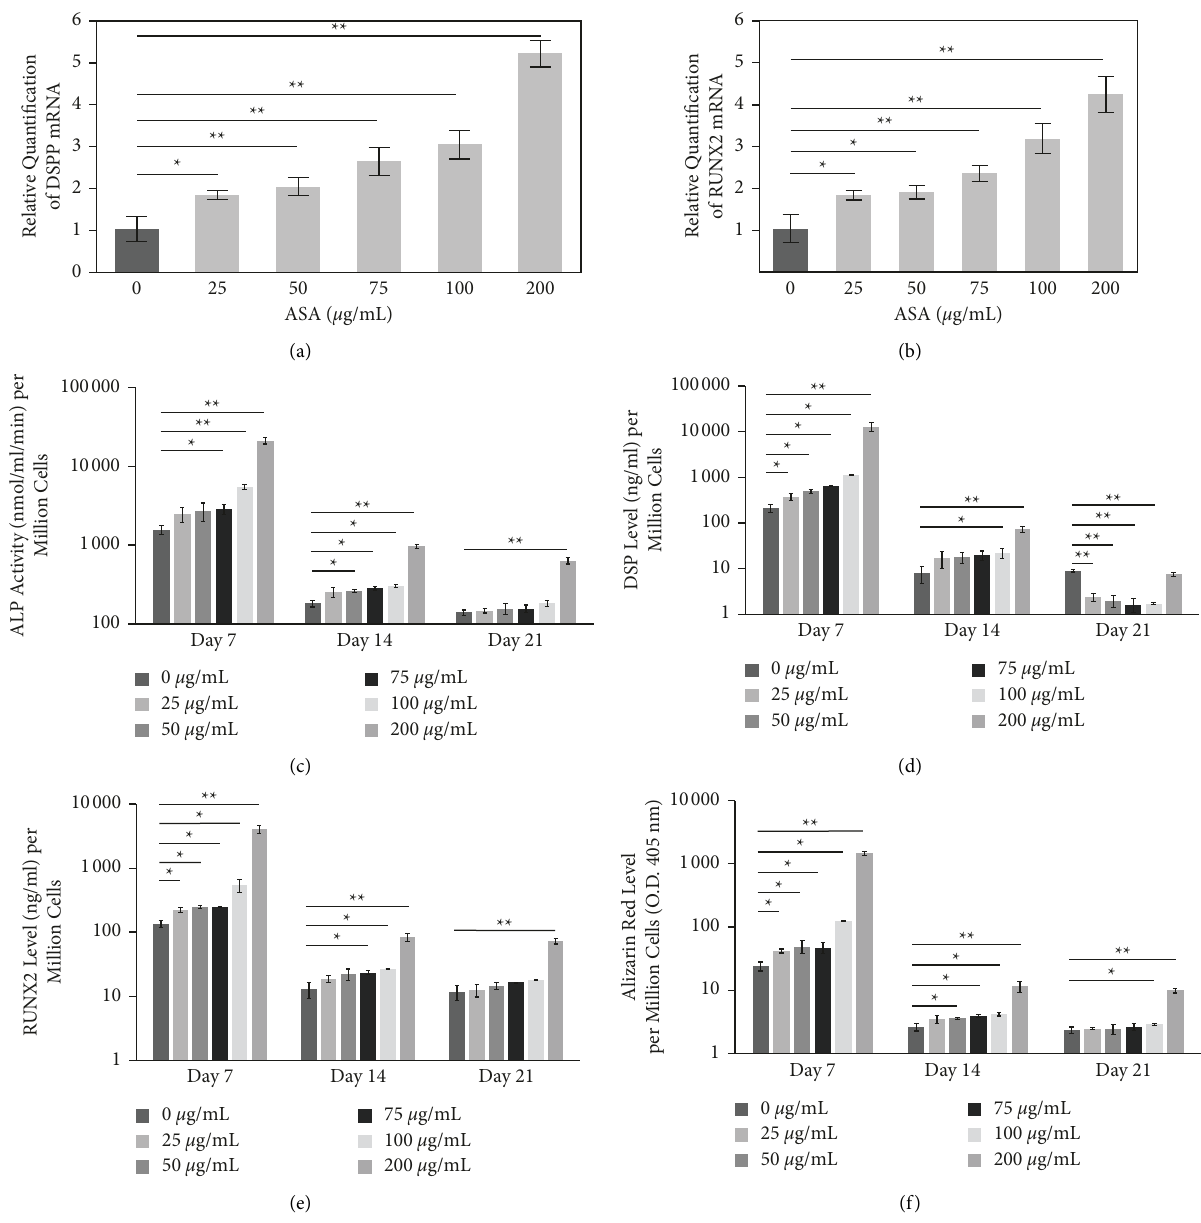
Figure 4: The effects of acetylsalicylic acid (ASA) treatment enhanced the odontogenic capacity of human dental pulp cells (HDPCs) in a dose-dependent manner. (a, b) Reverse transcription-quantitative polymerase chain reaction (RT-qPCR) demonstrated the dentin sia- lophosphoprotein (DSPP) and runt-related nuclear factor 2 (RUNX2) gene expression levels of HDPCs at 14 d of odontogenic induction ( n 6). Results showed the ratios to the control. (c-e) Alkaline phosphatase (ALP), dentin sialoprotein (DSP), and RUNX2 biomarker levels (cid:29) were evaluated after 7, 14, and 21 d of odontogenic induction ( n 4). (f) Alizarin red staining showed that high concentrations of ASA (cid:29) significantly promoted the mineralization of HDPCs after 7, 14, and 21 d of treatment ( n 6). The biomarker and alizarin red levels were (cid:29) normalized to cell numbers per million cells showing that the production per cell decreased over